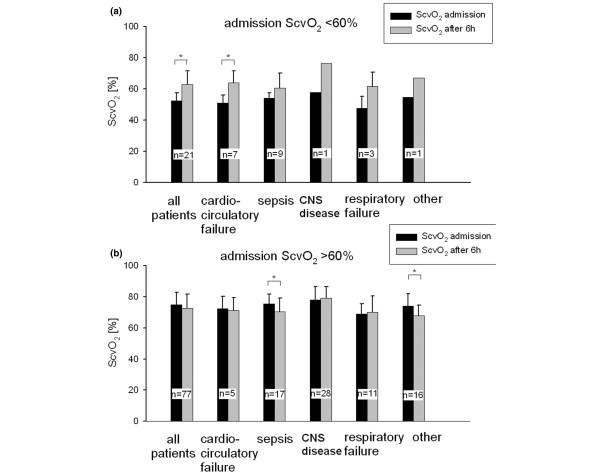
Central venous oxygen saturation (ScvO2) trends in the different patient groups. Trends are divided into an intensive care unit admission ScvO2 of less than (a) and greater than (b) 60%. ScvO2 is displayed as mean ± standard deviation. *Student's paired t test, p < 0.05, versus admission ScvO2. CNS, central nervous system; n, absolute number of patients per subgroup.